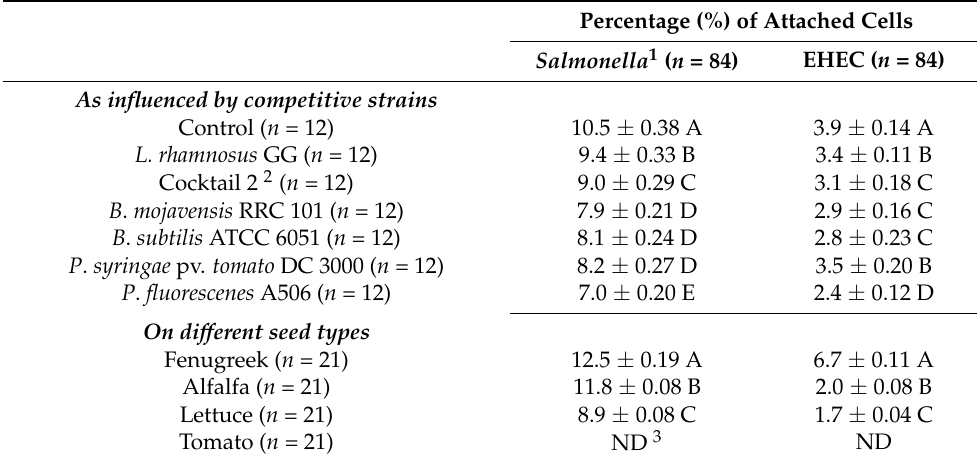
Table 5. Mean percentages of attached cells of the four-strain S. enterica or EHEC mixtures as affected by individual competitive bacterial strains and their